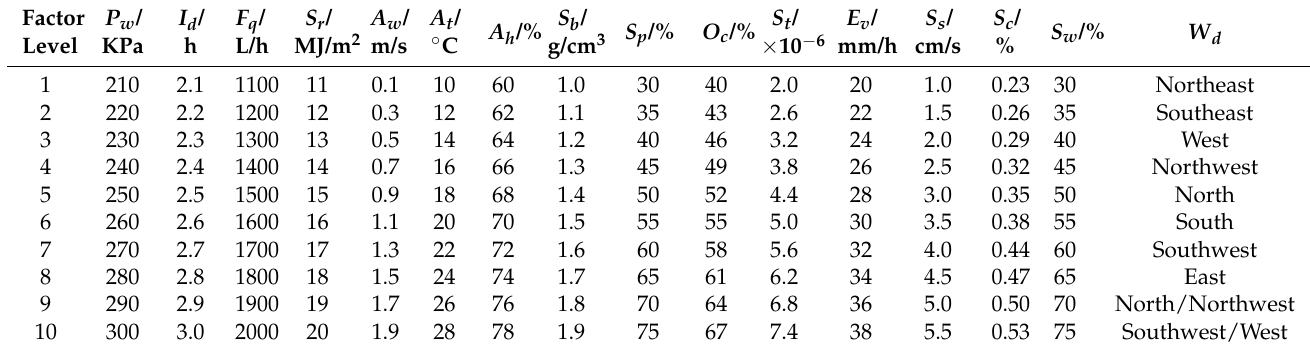
Table 3. Partitioned levels of sprinkler drip irrigation parameters.